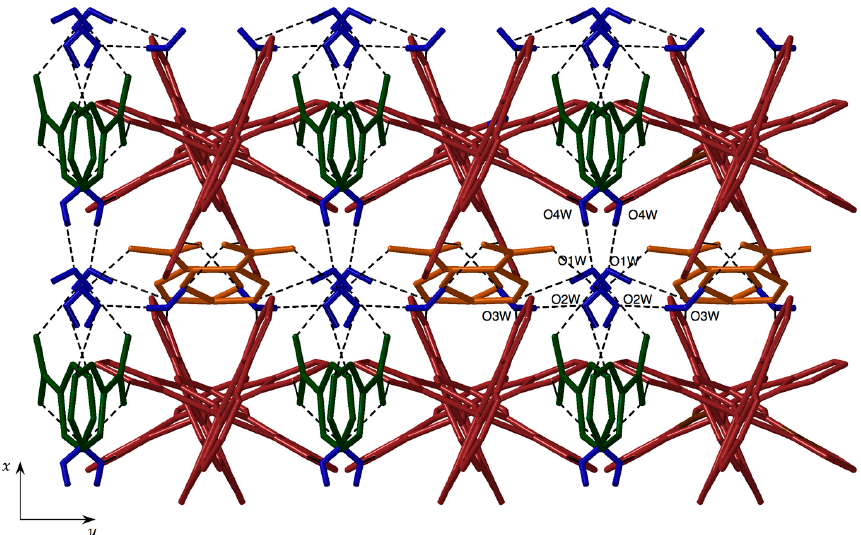
Figure 4. A view of the 2D packing of 1 · 4H 2 O along the c axis, showing the two different kinds of water molecules that are represented in blue: those filling the voids (O1W and O2W), and those forming the layers (O3W and O4W). Only the H atoms of water molecules are shown.